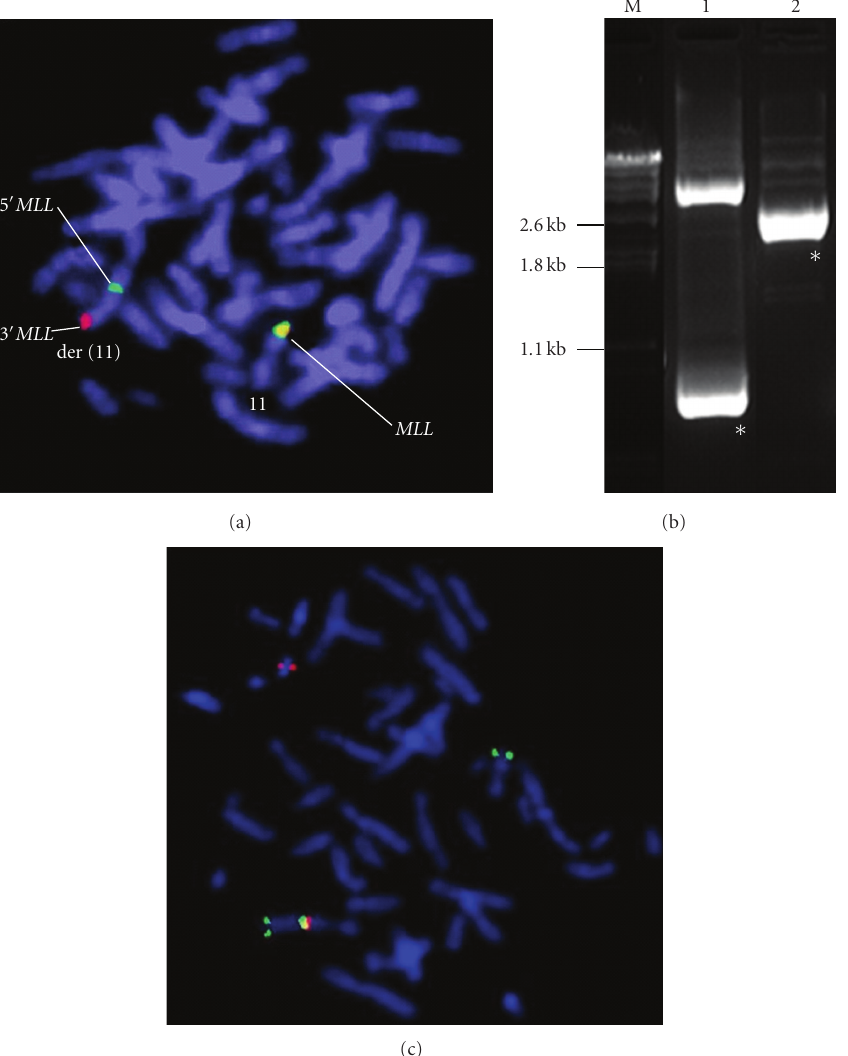
Figure 3: Identification of a new partner gene, FLNA , fused to MLL in acute myelomonoblastic leukemia. (a) FISH with dual-color MLL probe showing the insertion of chromosomal material within the disrupted signal of the MLL gene on the der(11). The yellow signal of the normal MLL is seen on the normal chromosome 11. (b) LDI-PCR of analyzed patient. The wild-type band in lane 2 does not appear. M: λ -Clal marker, 1: der(11), 2: der(reciprocal partner gene), ∗ : derivative band. (c) FISH with BAC clones CTD-2238E23 ( FLNA ) (labeled in Spectrum Orange) and RP11-91A14 ( MLL ) (labeled in FITC) showing two green signals, two red signals and one yellow